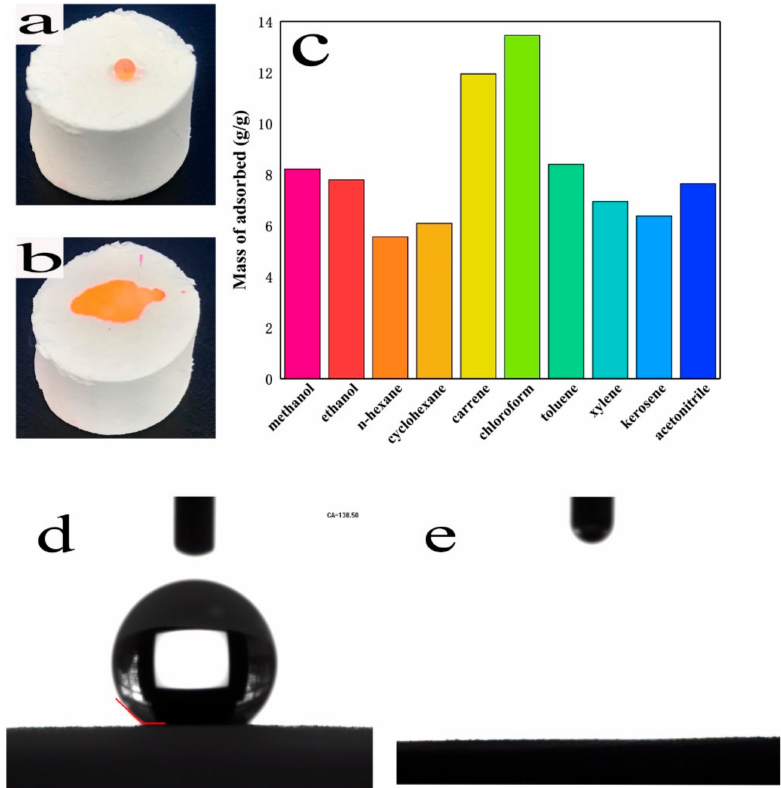
Figure 5. ( a ) Hydrophobicity: photograph of a water droplet; ( b ) Lipophilicity: photograph of ethanol on the surface of sample (the water and ethanol were colored with rhodamine 6G for clear presentation); ( c ) Absorption capacity of aerogel-like monoliths for di ff erent organic liquids; ( d ) Water contact angle of the monoliths; ( e ) Water droplet was completely absorbed by the thermally treated products in water contact angle test.